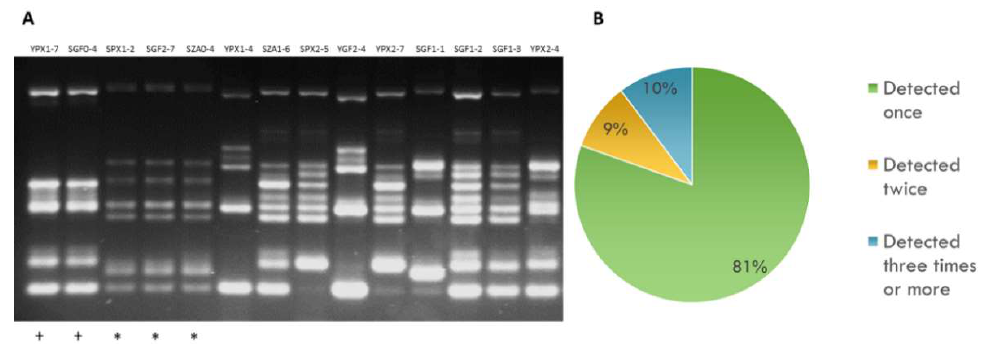
Figure 1. Broad genetic diversity of autochthonal wine yeasts in Aljarafe vineyards. ( A ). Representa- tive examples of microsatellite-PCR patterns obtained in 150 S. cerevisiae colonies isolated from five spontaneous fermentations of must different grape varieties in two independent vineyards. Colonies were isolated from samples taken as grapes were milled and after 1 and 2 weeks of fermentation. Strains with a common pattern were identified in samples from the two studied vineyards (+) as well as in different grape varieties of the same vineyard (*). Each lane is labelled with the strain name. ( B ) Percentage of strains with microsatellite patterns detected once, twice and three or more times. A total of 97 unique microsatellite patterns were distinguished among the 150 isolates, most of them detected only once.